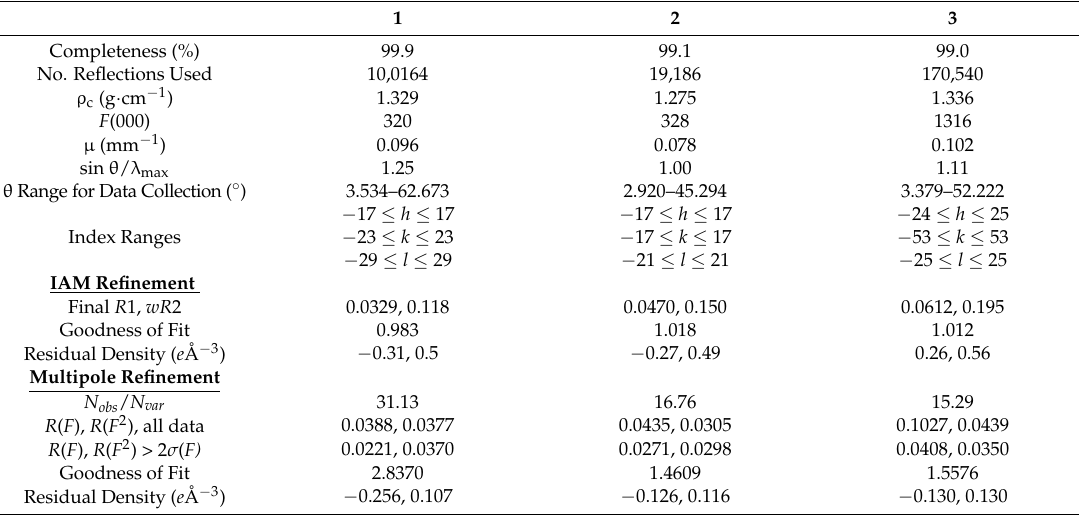
Figure 3. ORTEP diagram of 44BP ( 2 ). Thermal ellipsoids are shown at the 50% probability level [24].